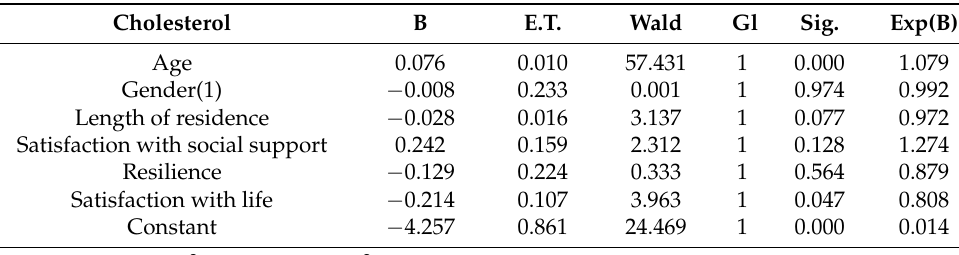
Table 5. Logistic regression analysis on cholesterol and chronic